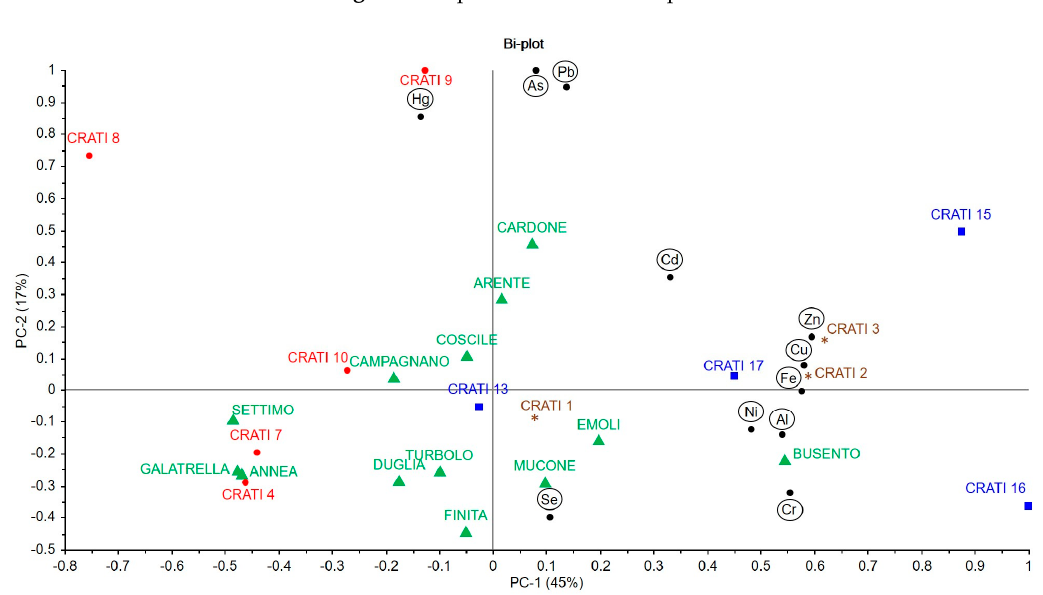
Figure 4. Bi-plot of the sediment samples.